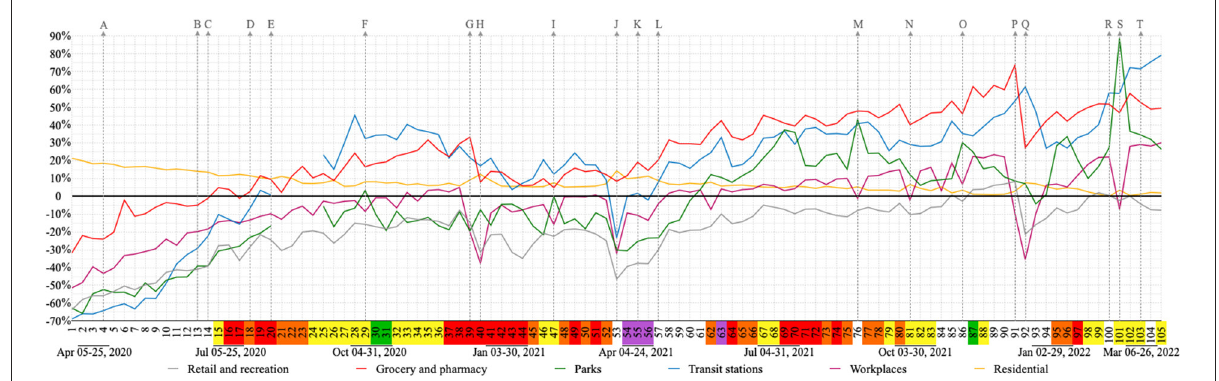
FIGURE8 Impact of decrees and holidays on community mobility per week. Decrees: (A) face mask mandatory; (B) reopening industries; (C) bus 100% capacity and total hours 16/day; (D) reopening several business and social segments; (J) lockdown; (K) rotation by company registry number; (L) flags no longer regulate business and social segments; (R) decree commercial events one meter social distancing; (T) decree for a more flexible mask use. Holidays: (E) Father’s day 2020 (Sun); (F) Nossa Senhora Aparecida 2020 (Mon); (G) Christmas 2020 (Fri); (H) New year 2021 (Fri); (I) Carnival 2021 (Tue); (M) Independence day 2021 (Tue); (N) Nossa Senhora Aparecida 2021 (Tue); (O) Proclamation of the republic and black awareness day 2021 (Mon and Sat); (P) Christmas 2021 (Sat); (Q) New year 2022 (Sat); (S) Carnival 2022 (Tue). Flag colors: green, very low; yellow, low; orange, moderate; red, high; purple, very high risk.